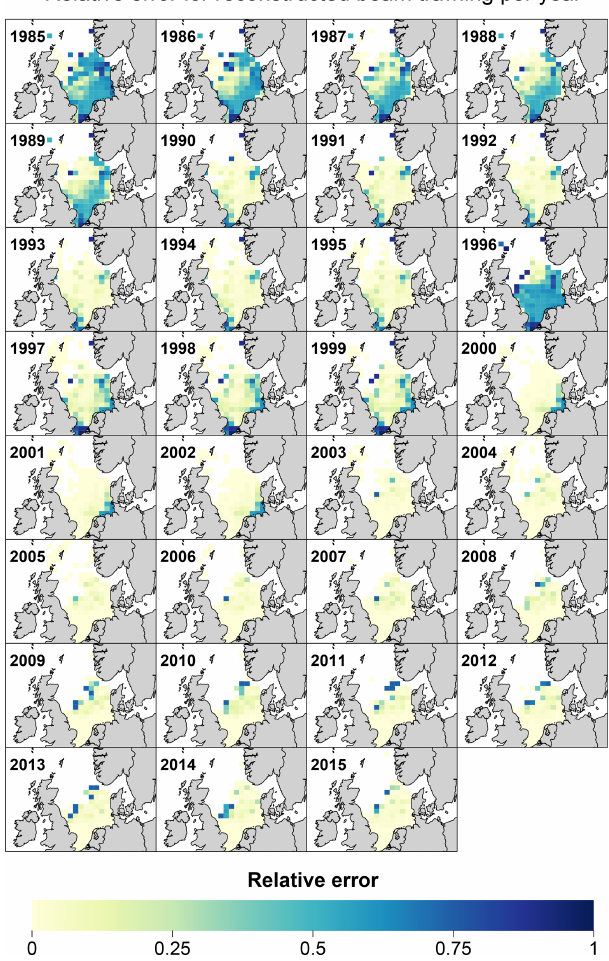
Figure 5. Spatial distribution of relative error of the reconstructed beam trawling effort (i.e. the ratio between the error of the estimated effort and the total reconstructed effort) per ICES rectangle in the North Sea in